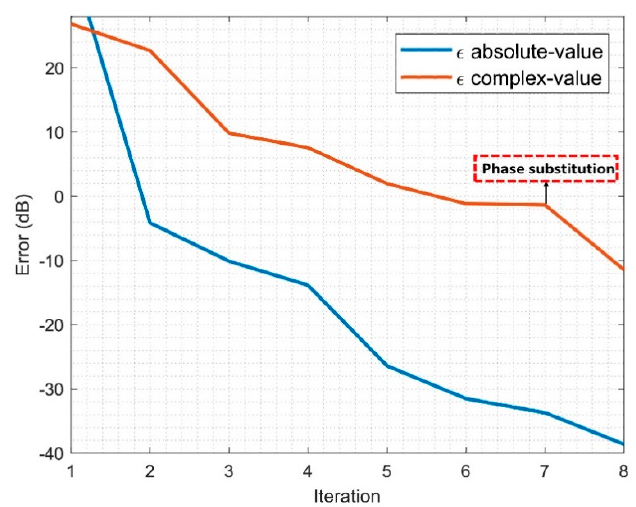
Figure 8. Iterative algorithm evolution.